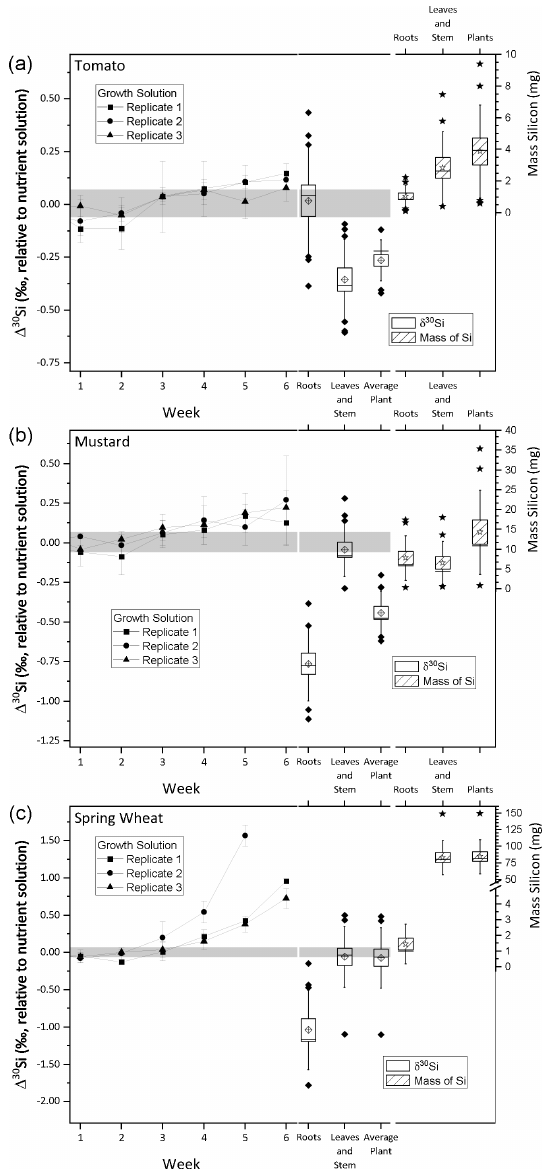
Figure 2. Silicon isotope composition and mass of silicon taken up during the growth of tomato (a) , mustard (b) , and wheat (c) . The left y axis shows the δ 30 Si in per mille relative to the nutrient solution. The right y axis shows the mass of silicon incorporated by the plants in milligrams. The line connects δ 30 Si from the weekly sampled nutrient solution (weeks 1 to 6). The box plots denote δ 30 Si (left) and plant organ Mg mass (right). Per species 12 roots and 12 leaves and stem samples were analysed, and plant averages were weighted by organ mass (calculated using Eq. 2). Uncertainty bars are based on 2 standard uncertainties, and the grey area denotes the silicon isotopic composition of the starting solution ± 2 standard deviations. All box sizes denote 1 standard uncertainty, whiskers indicate 1 standard deviation, the horizontal line in the box shows the median, empty diamonds and stars in the box indicate the mean, and filled diamonds and stars show outliers, outside of 1 standard deviation.